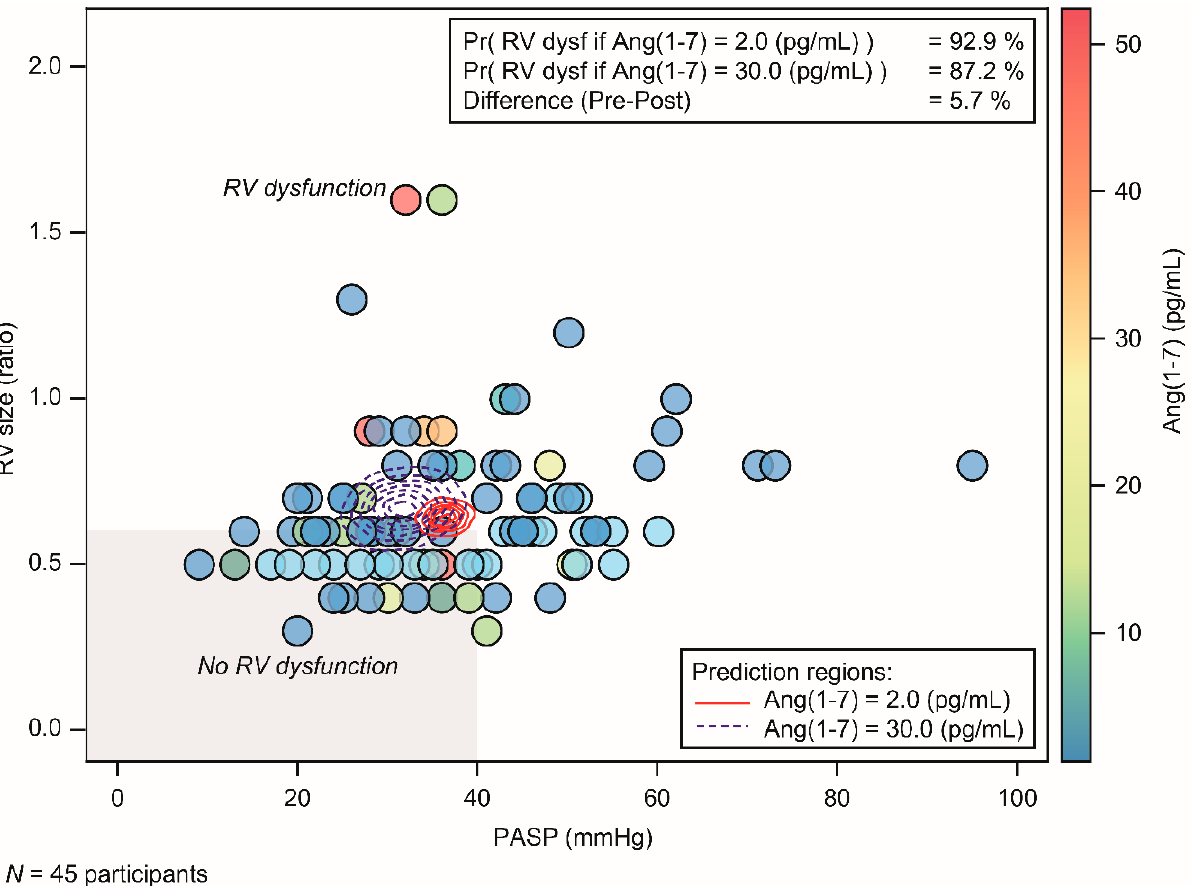
Figure 6. Scatterplot of PASP versus RV size ratio, marked by interventricular septal motion status and colored by Ang(1–7) concentration, with posterior prediction regions for PCD measurements for hypothetical ‘pre-‘ and ‘post-‘dose Ang(1–7) concentrations. Data are for ‘pre-dose’ 2 pg/mL and ‘post-dose’ 30 pg/mL Ang II concentrations. The horizontal reference lines correspond to the defined threshold value for PCD . Ang , angiotensin; PASP , pulmonary arterial systolic pressure; Pr , probability; RV , right ventricular.